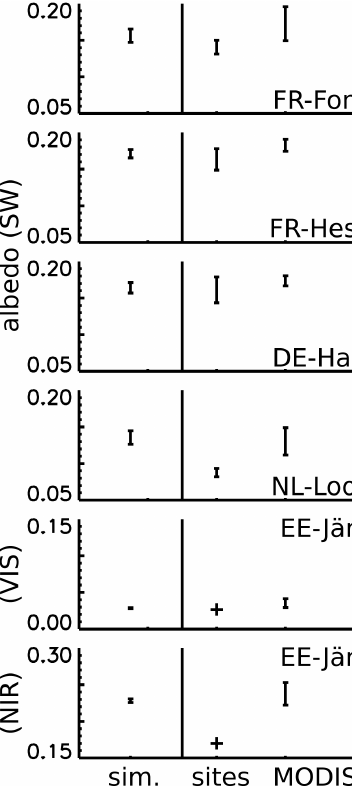
Fig. 2. Comparison of simulated June albedo for five different sites (left column) to in situ and satellite observations. The range of sim- ulated albedo is shown for different crown allometry used to esti- mate crown volume from observed tree diameters. The range of in situ observations is taken from the 2h window centred on local so- lar noon in June at each site during the years 1999 and 2010. EE-Jär is a single measurement (6 March 2013) but separated into visible and near-infrared albedo. The range of MODIS (2001–2010) obser- vations are derived from nine pixels surrounding the tower. DE-Hai: beech; FR-Hes: beech; FR-Fon: oak; EE-Jär: pine; NL-Loo: pine. Table 4. Maximum range of changes in summertime canopy albedo between managed and unmanaged forest over one rotation driven by thinning strategies, across all species and solar zenith angles; by species, across all thinning strategies and solar zenith angels; and by solar zenith angle, across all thinning strategies and species. For more explanation, see Table 1.